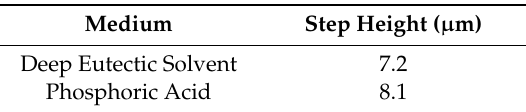
Table 3. Average recorded step heights in µ m for each metal after treatment with the respective electrolytes at 70 ◦ C for 900 s.